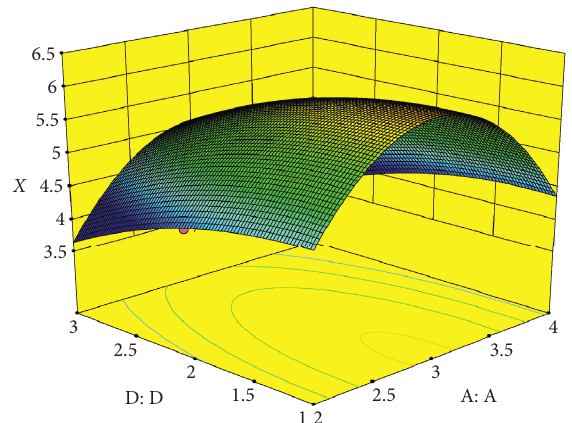
Figure 10: The interaction term AD.